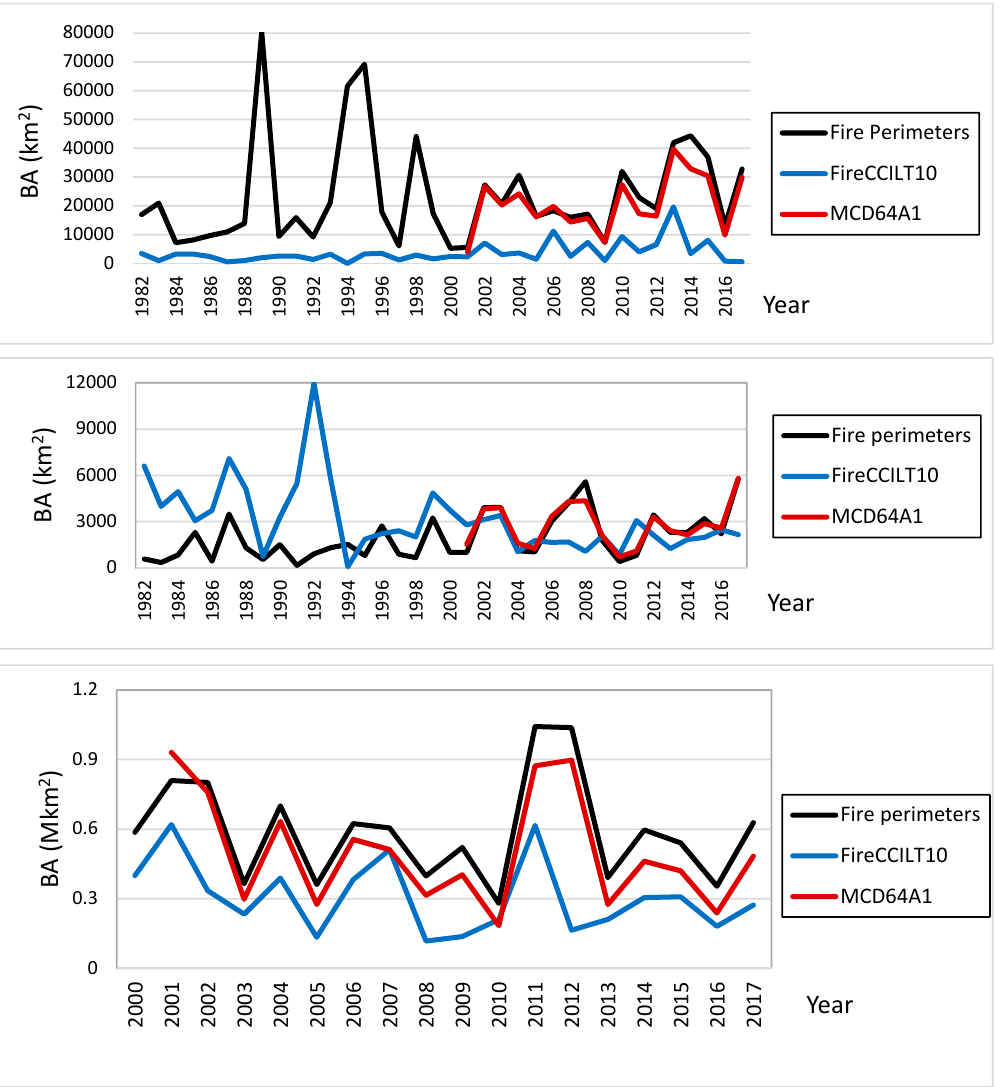
Figure 16. Comparison of the BA trends between FireCCILT10, MCD64A1, and the national fire perimeters: Canada ( top ), California ( center ), and Northern Australia ( bottom ). Note that the vertical scale is quite different among sites, as they have very different fire occurrences.